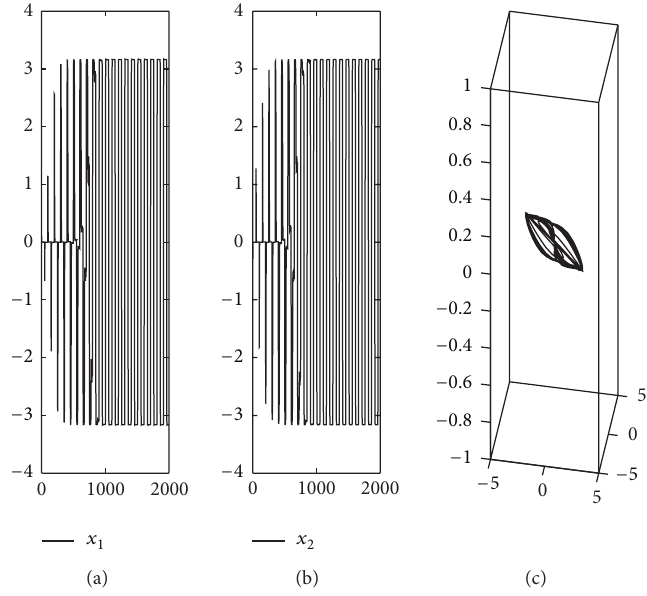
Figure 3: The system (1) undergoes a Hopf bifurcation at (0,0) with sufficiently large 𝜏 = 50